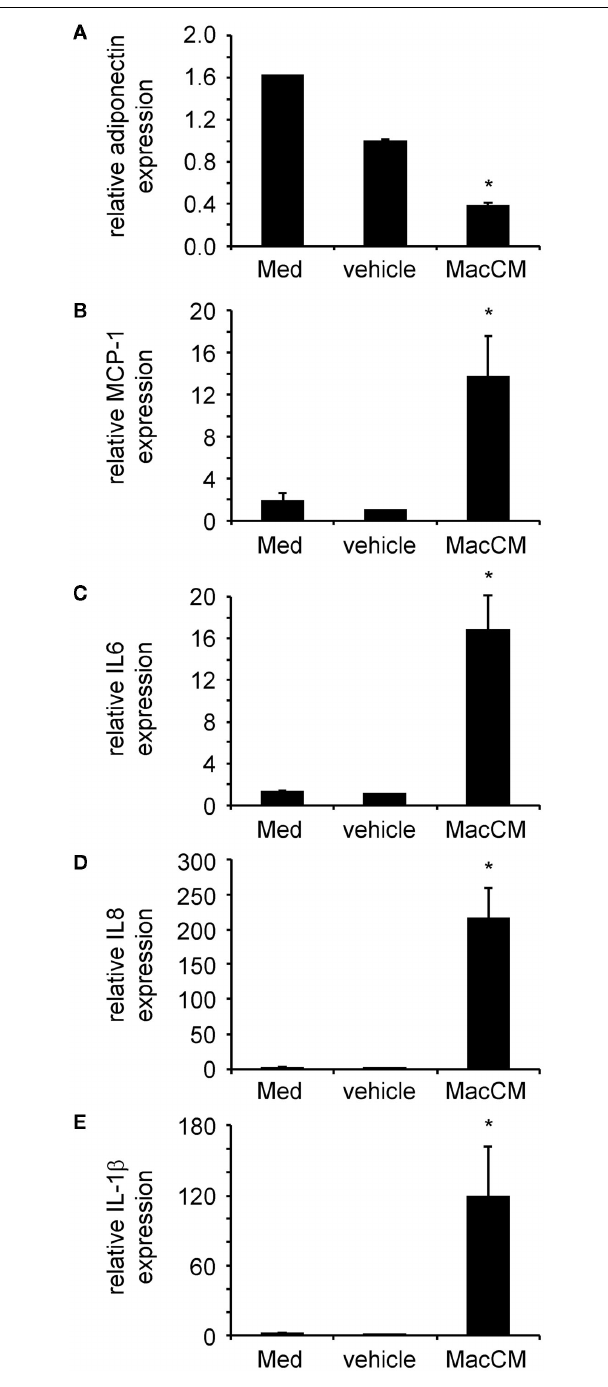
FIGURE 3 | Macrophage-conditioned medium (MacCM) differentially regulates adipokine expression. SGBS adipocytes were incubated with medium, vehicle control, or 50% MacCM. After 24h total RNA was prepared and reversely transcribed. Expression of adiponectin (A) , monocyte chemoattractant protein-1 (MCP-1) (B) , interleukin-6 (IL6) (C) , interleukin-8 (IL8) (D) , and interleukin-1beta (IL1 β ) (E) was analyzed by qPCR.The mRNA levels of target genes were normalized to those of succinate dehydrogenase complex subunit A (SDHA) using the Δ Ct method and related to vehicle control using ΔΔ Ct method. Data are presented as mean + SEM of three independent experiments. * p <